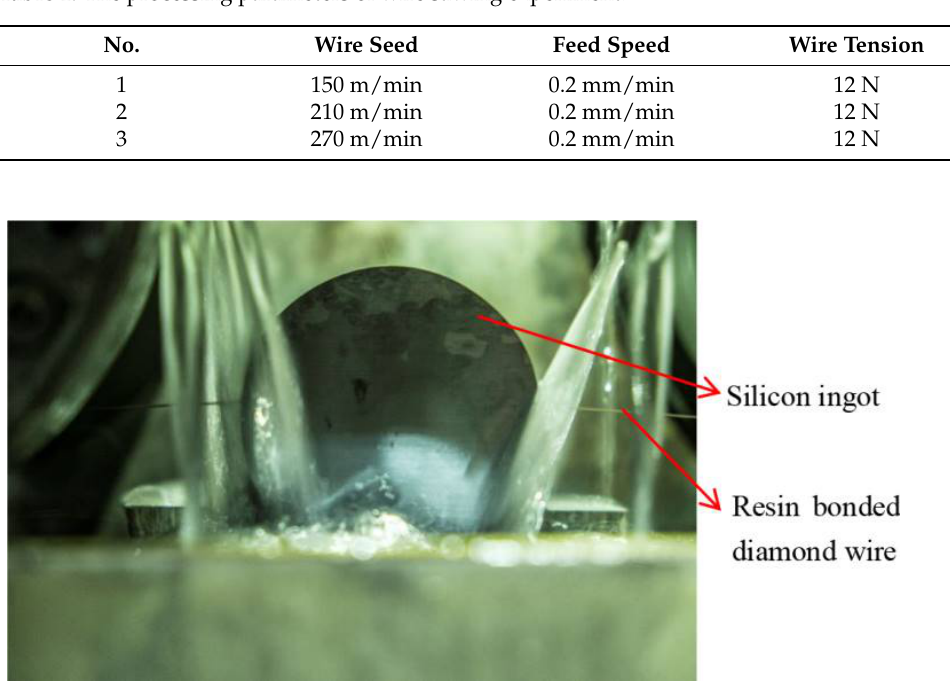
Table 1. The processing parameters of wire sawing experiment.